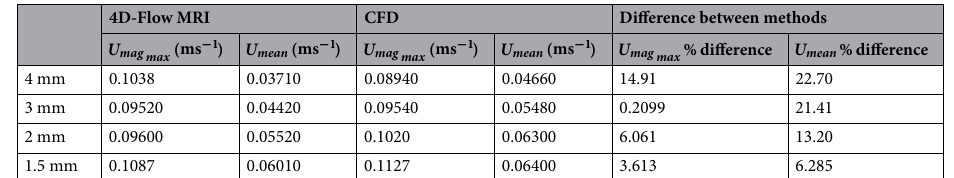
1 Table 5. Velocity magnitude ( ms − ) data at the inlet plane during diastole calculated using 4D-Flow MRI data and CFD data, including a comparison between the two methods for each spatial resolution.